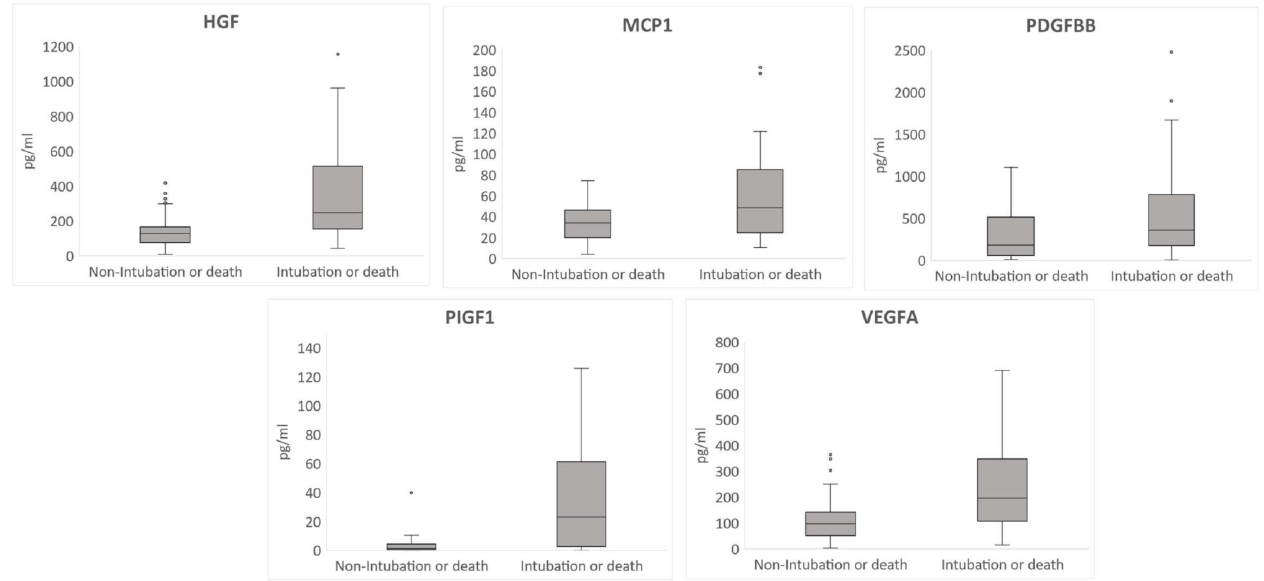
Figure 1. Box plot diagram showing the statistically significant cytokine levels according to intubation or death. Hepatocyte Growth Factor (HGF), Monocyte Chemoattractant Protein-1 (MCP1), Human Platelet-Derived Growth Factor-BB (PDGFBB), Human Placental Growth Factor 1 (PIGF1), Vascular Endothelial Growth Factor A (VEGFA). The dots on the box plot diagrams indicate the outlier